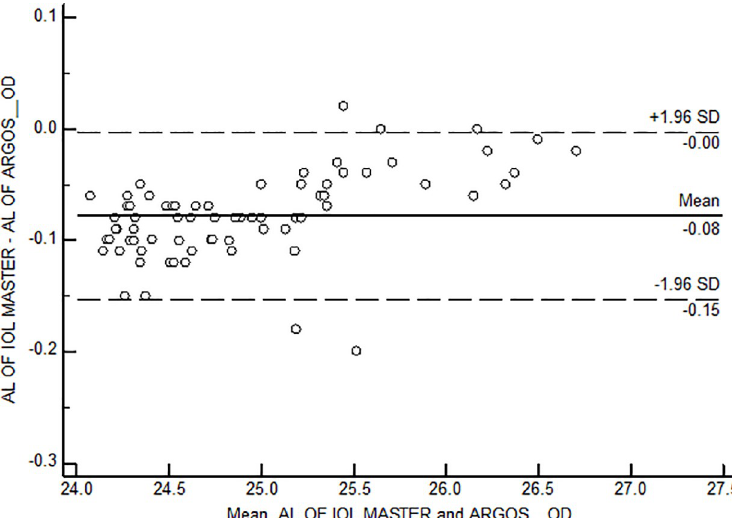
Fig 8. Bland Altman Plot for agreement between axial length measurements among long axial length group. AL-Axial length; OD–Right eye.